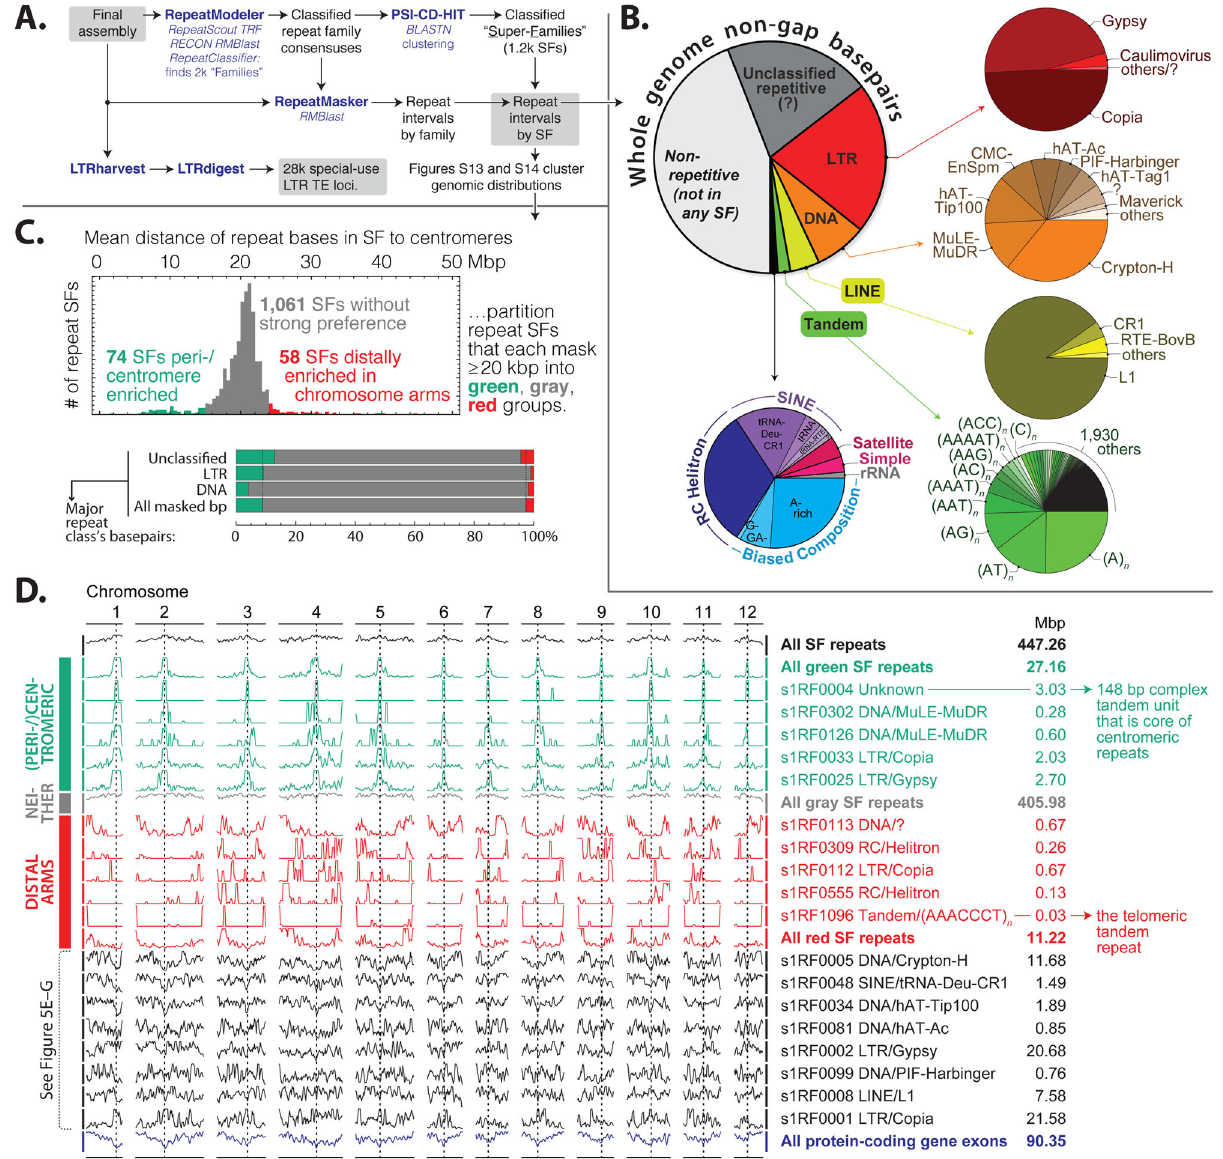
Fig. 3 Dispersed and local (tandem/satellite, simple/biased composition) repetitive sequence in Q. lobata . A Primary analysis outline. B Assembly partitioned into RepeatClassi fi er/RepeatMasker major and minor classes; 54% of non-gap base pairs are covered by repeat superfamilies (SFs), and transposable elements (TEs) are prevalent. C Unsupervised comparisons of how the 1193 individual SFs each with ≥ 20 kbp distribute across chromosomes (Supplementary Figs. 13 and 14) suggest the primary distributional diversity at chromosome scale is proximity to centromeres (green, 74 SFs totaling 27 Mbp) vs. telomeres (red, 58 SFs totaling 11 Mbp) vs. more-or-less uniformity (gray, 1061 SFs totaling 406 Mbp). D Chromosomal distribution of selected SFs and sets of SFs, illustrating the diversity across and within the trichotomy of C . The y -axis in each row is linear number of member base pairs in 3 Mbp bins every 1 Mbp, with zero at the lower edge and 95th percentile (or row maximum if the percentile is zero) at the upper edge. Black rows near the bottom are the representative SFs of Fig. 5E –